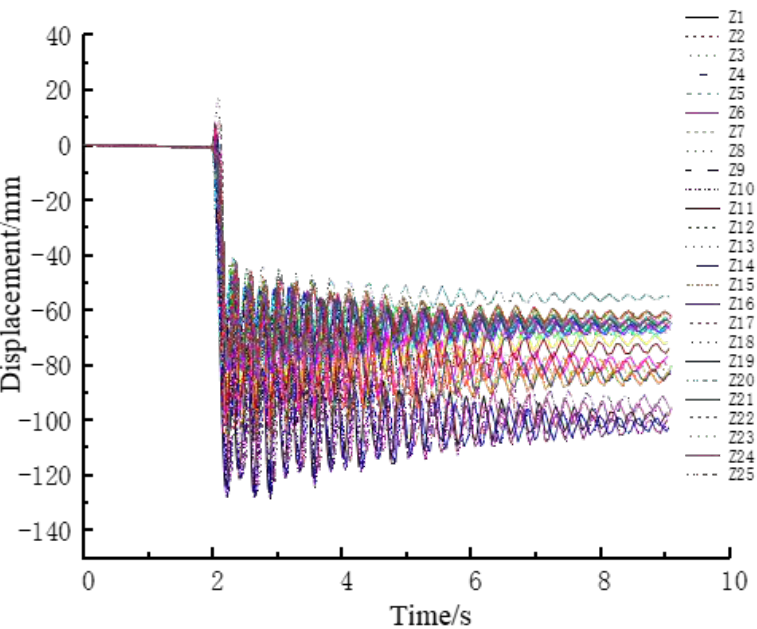
Figure 5. Vertical displacement of column top after bottom side column failure.